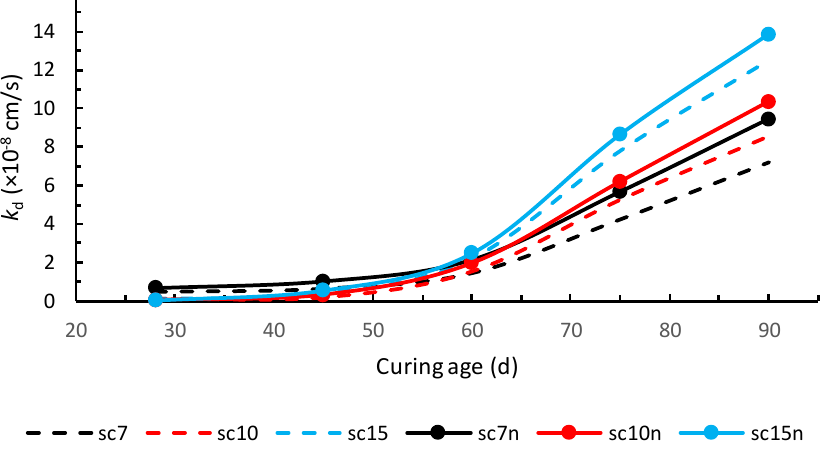
Figure 2. Comparison between the results presented in Reference [1] (sc7, sc10, sc15) with the results obtained from Equation (10) (sc7n, sc10n, sc15n).